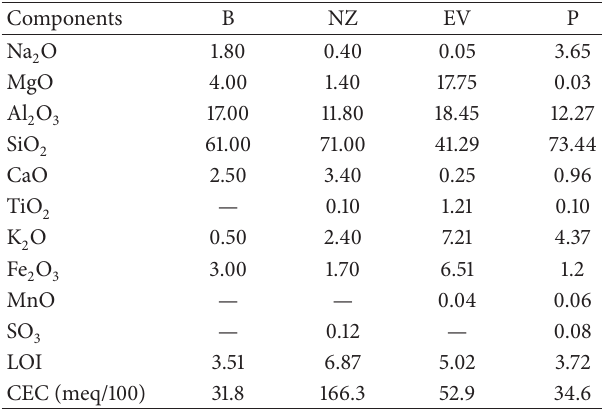
Table 1: Chemical compositions of the liner materials.